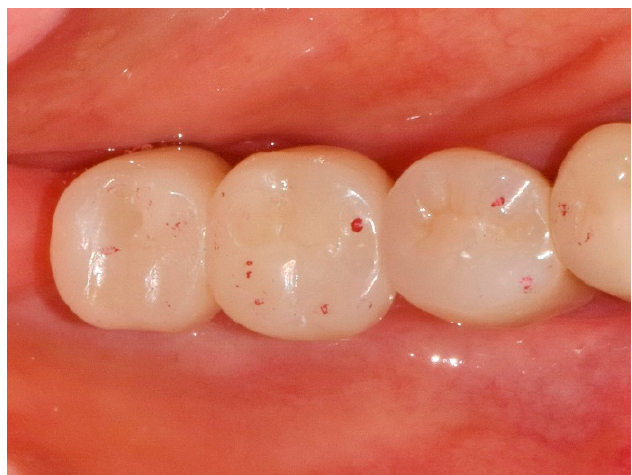
Figure 5. Follow-up image 8 months after the end of the treatment.